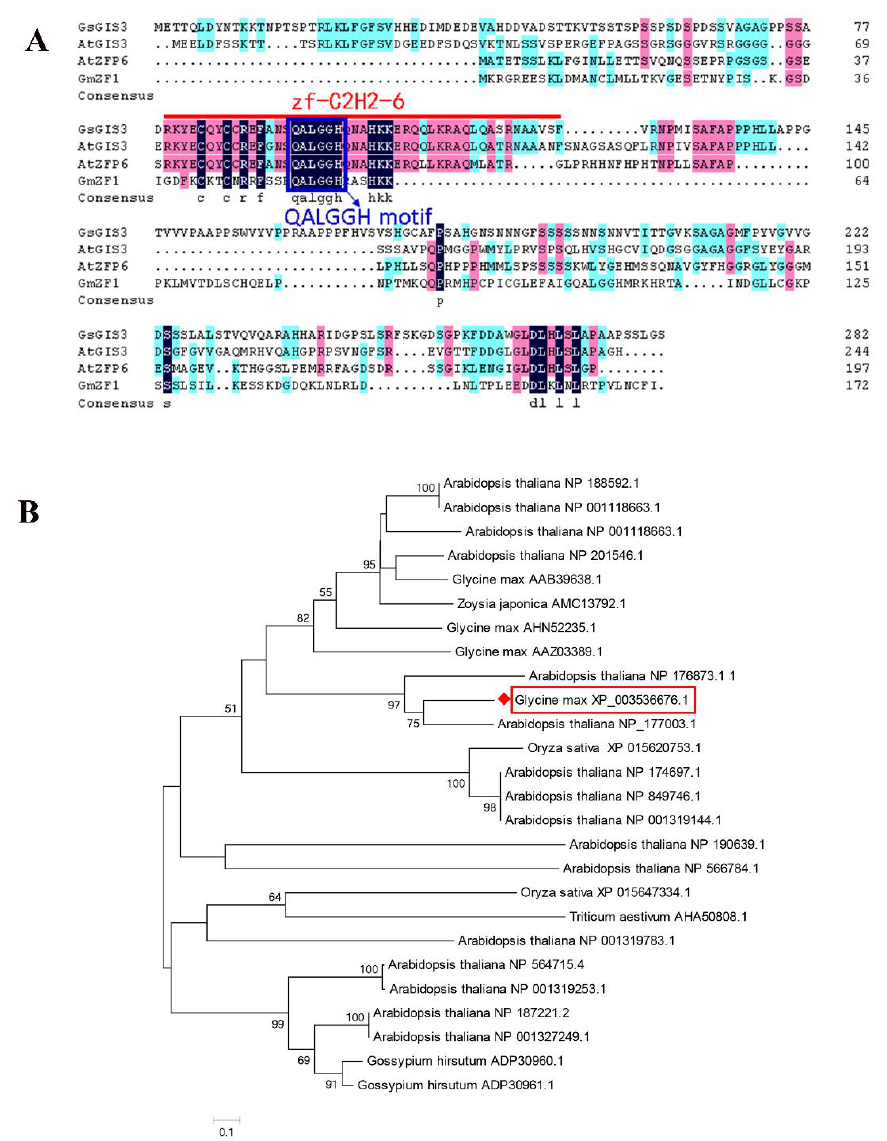
Figure 1. Amino acid sequence and phylogenetic analysis of GsGIS3. ( A ) The alignment of C2H2 zinc finger proteins. The position of the domain of zinc finger is labeled. GsGIS3 (XP_003536676.1), AtGIS3 (NP_177003.1), AtZFP6 (NP_176873.1), and GmZF1 (AAZ03389.1). ( B ) Phylogenetic analysis of GsGIS3 protein orthologs. The GsGIS3 protein is marked with a red box.